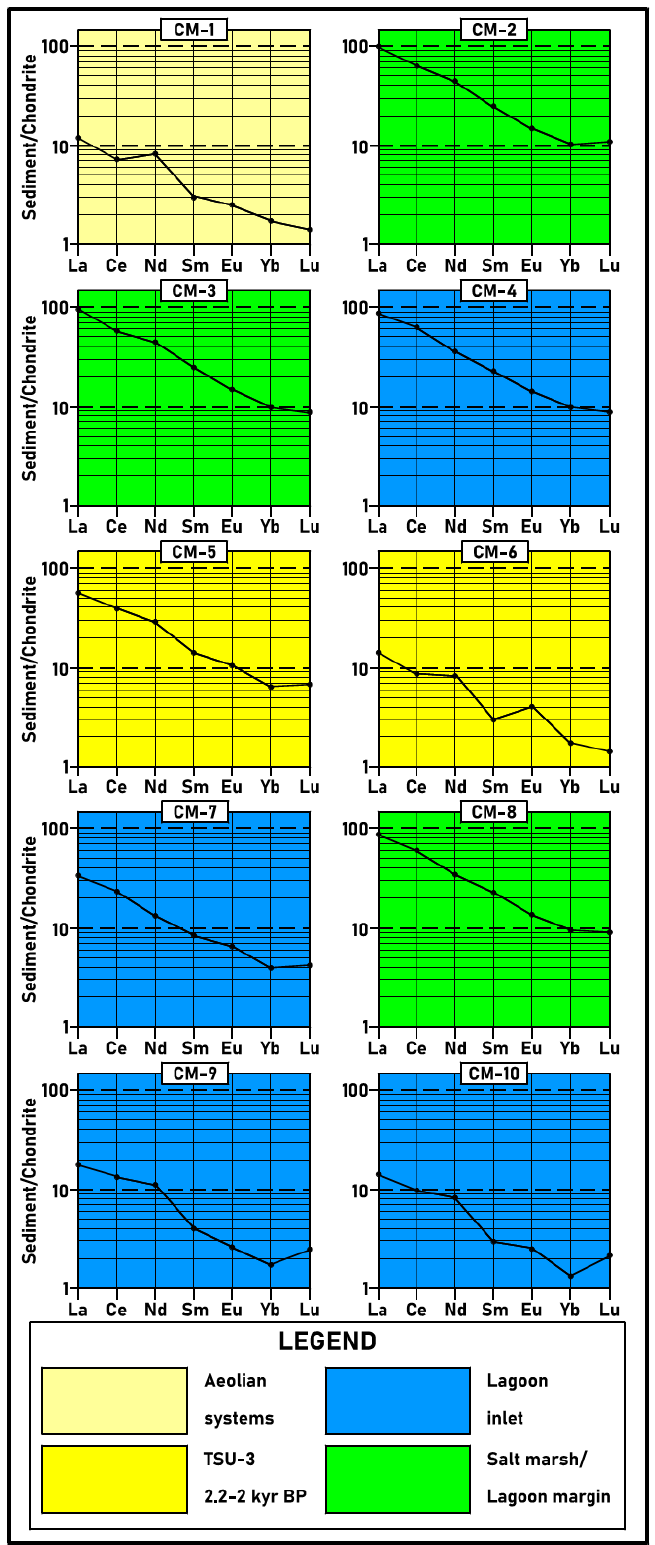
Figure 11. REE abundances normalized to chondrite values in core CM. The Y axis is in a logarithmic scale.